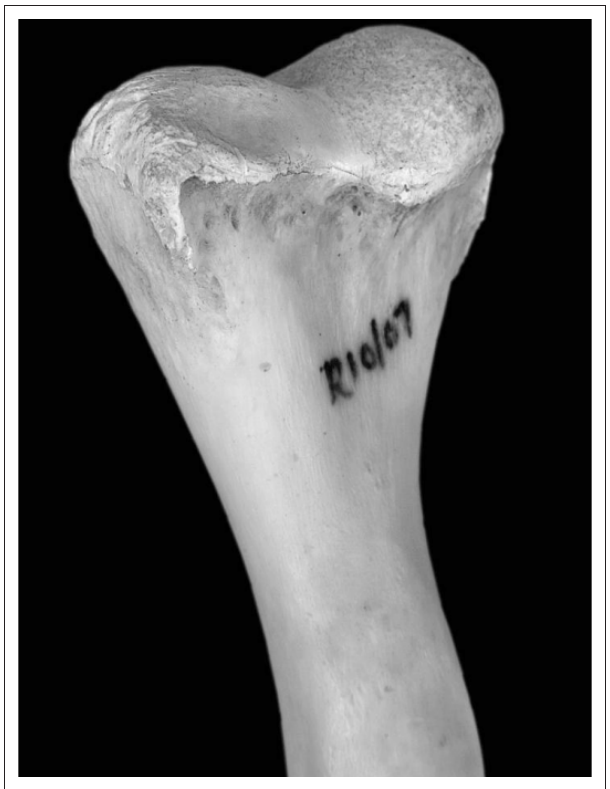
FIGURE 6: Humerus of an adult Nile crocodile, case 4: Partial collapse of the distal articular surface of the